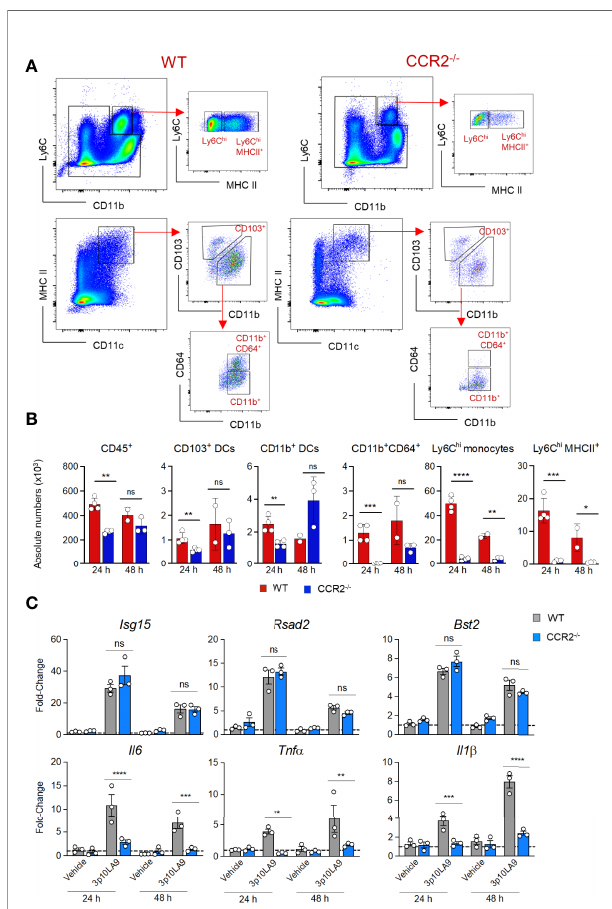
FIGURE 5 | RIG-I agonist-dependent monocyte recruitment leads to a transient in fl ammatory response in the lungs. (A) Representative fl ow cytometry dot plots showing pulmonary Ly6C hi monocytes and Ly6 hi HCII + monocytes and distinct DC subpopulations (CD103 + DCs, CD11b + DCs, CD11b + CD64 + DCs) of intranasally 3p10LA9 treated WT (left panel) and CCR2 -/- mice (right panel). Lungs were collected 24 h post-delivery. (B) Absolute numbers of pulmonary CD45 + cells, CD103 + DCs, CD11b + DCs, CD11b + CD64 + DCs, Ly6C hi monocytes and Ly6 hi MHCII + monocytes in WT and CCR2 -/- mice. Lungs were collected 24 h and 48 h post-3p10LA9 treatment. The error bars represent the SEM (n= 2-4 mice). * P < 0.05; ** P < 0.01; *** P < 0.001;**** P < 0.0001; ns, not signi fi cant; two-tailed t-Student ’ s Test. (C) Relative fold change in gene expression of indicated ISGs and cytokines was measured by qPCR. Lung homogenates were obtained from WT and CCR2 -/- mice 24 h and 48 h post-treatment (3p10LA9 and only